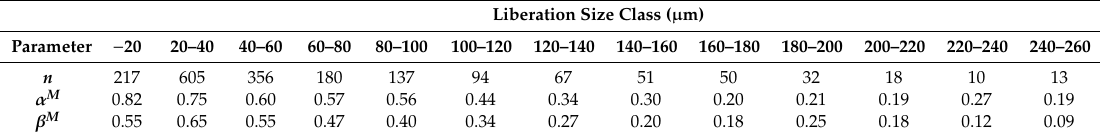
Figure 10. Beta distribution parameters of the ore obtained for a description of the mineral liberation of scheelite. Table 5. Estimated model parameters for mineral liberation modeling of